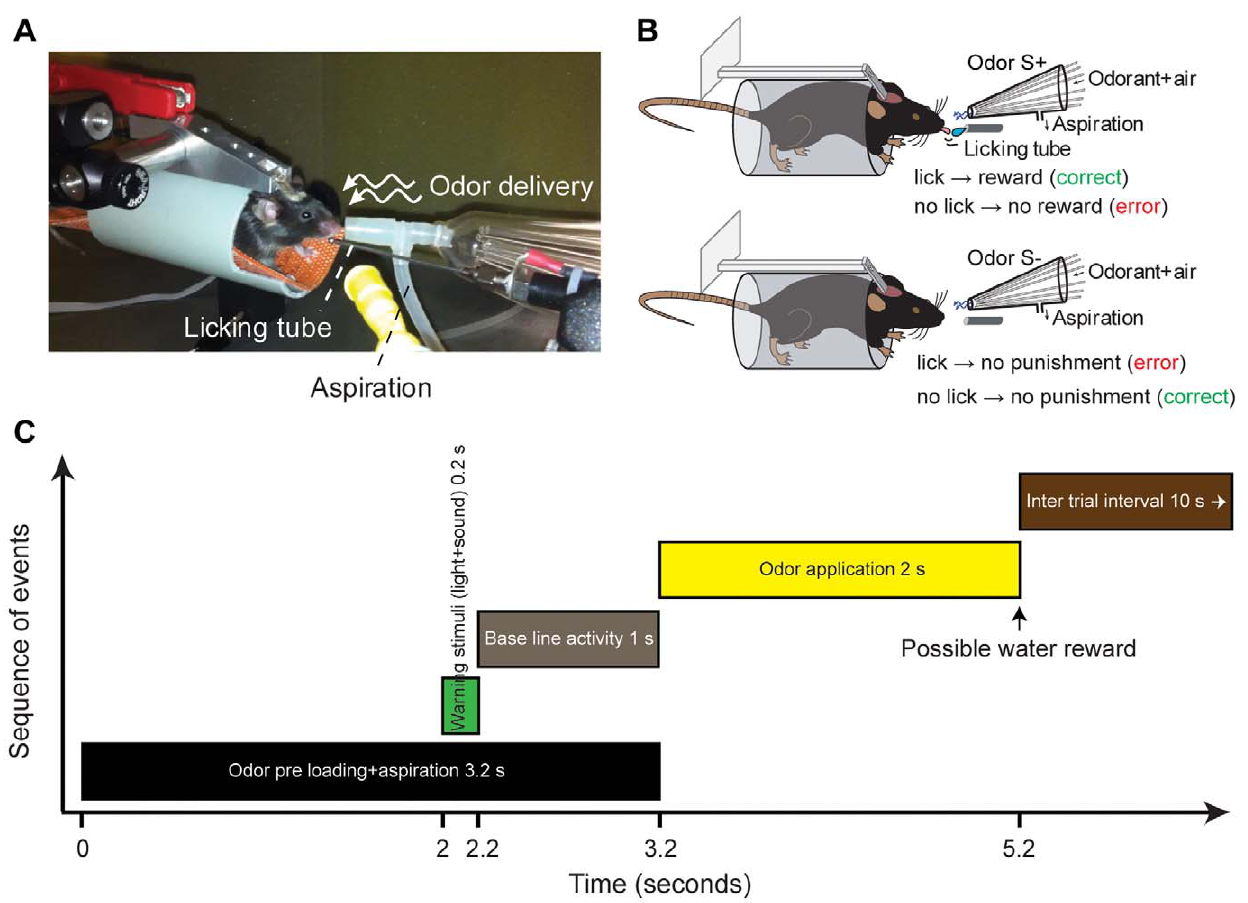
Figure 1. Go/no-go olfactory conditioning task under head-restrained conditions. ( A ) Mouse engaged in a go/no-go operant conditioning task. ( B ) Schema of rewarded and unrewarded trials. ( C ) Structure of a single trial. The criterion for a water reward was the total lick of 80 ms in three time bins of 500 ms out of four bins during the 2 s odor presentation, if there was no baseline licking. If mice were licking during the baseline, they had to lick double amount of time during the odor presentation to get the water reward.